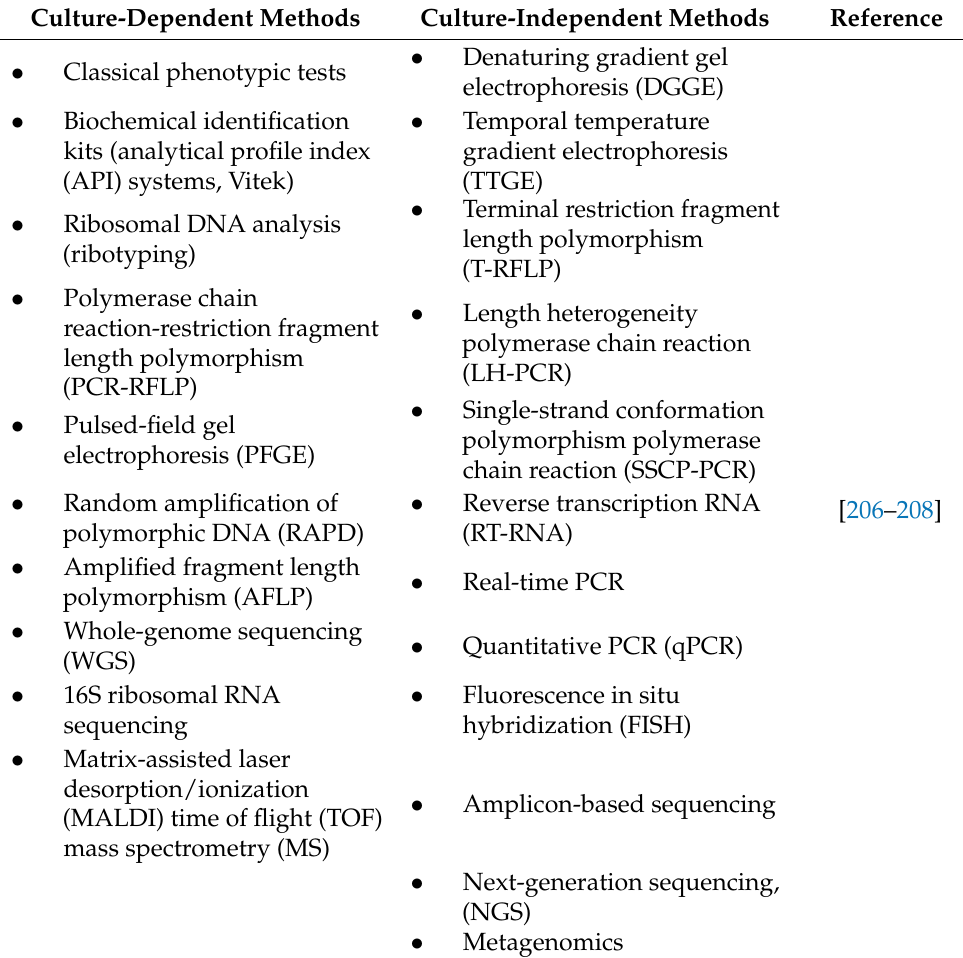
Table 4. The methods for the detection and analysis of